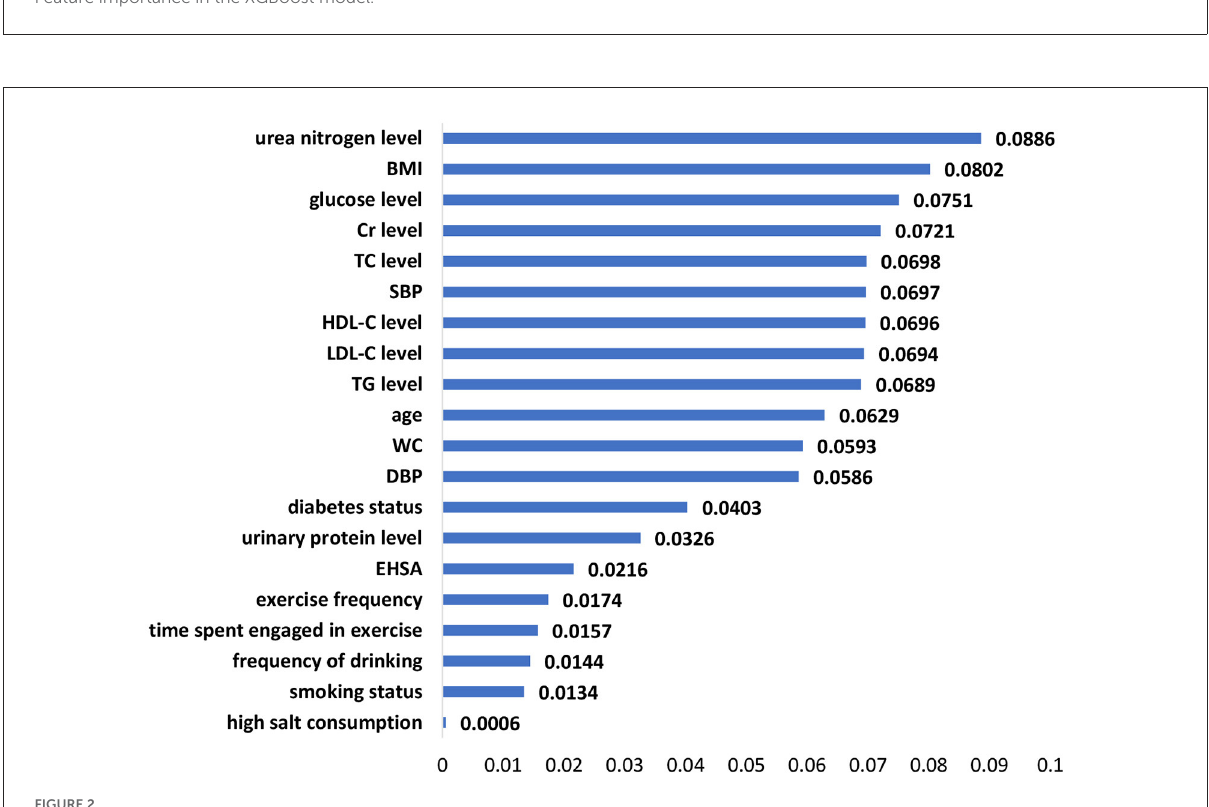
FIGURE2 Feature importance in the random forest